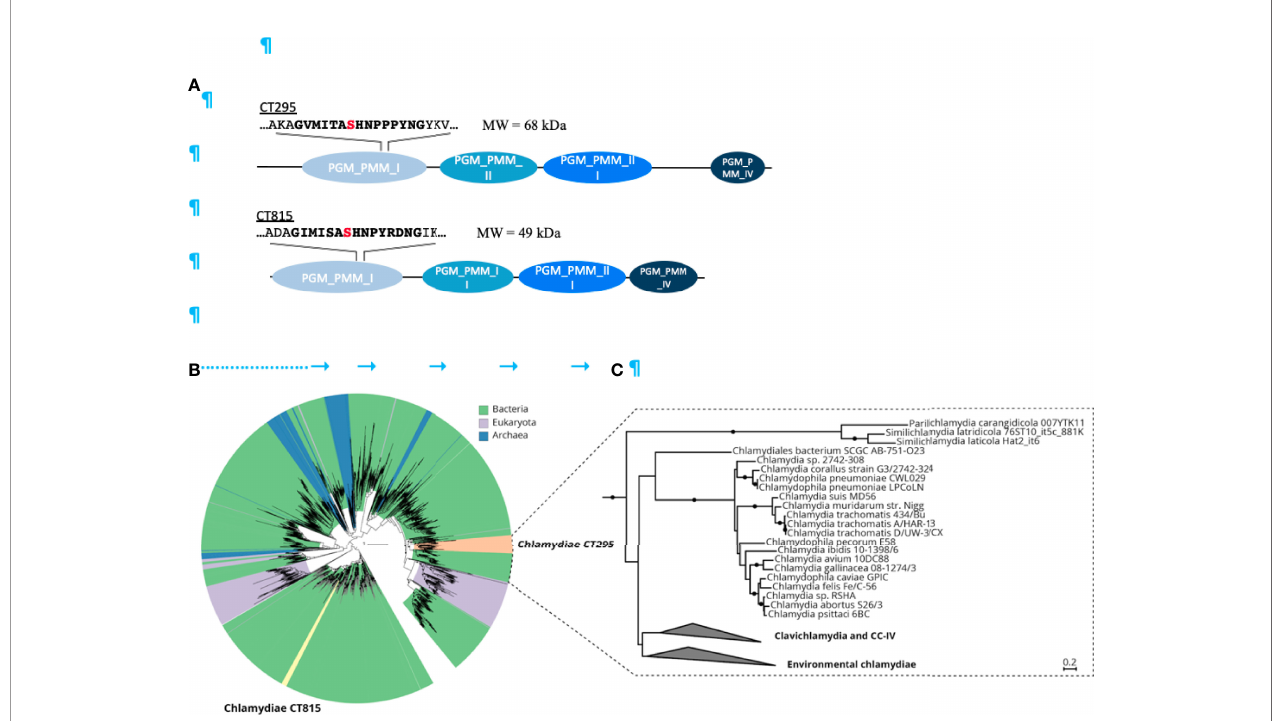
FIGURE 2 | The chlamydial candidate PGMs CT295 and CT815 are related with other bacterial PGMs, stem from an ancient gene duplication event and are both monophyletic. (A) – Schematic representation of the two putative PGMs from C. trachomatis . PGMs are composed of four phosphoglucomutase domains depicted in blue. The PGM conserved motif sequence is in bold with the serine involved in the phophoryl-transfer in red. (B) – Phylogenetic analysis of chlamydial CT295 and CT815 homologs in eggNOG COG1109 (annotated as “ phosphomannomutase ” ; 456 aligned positions) clustered at 80% amino acid identity over 90% query coverage (n = 2,829). Clades are colored by their af fi liation to bacteria, eukaryota, and archaea in green, violet, and blue, respectively. Orange indicates the chlamydial CT295 clade (bacterial eggNOG ENOG4107QSU), and yellow indicates the chlamydial CT815 clade (bacterial eggNOG ENOG4107QJF). Maximum likelihood phylogenetic trees with best fi t model LG+C60+G+F with 1,000 ultrafast bootstraps are shown. Bootstrap support for monophyly of chlamydial clades in the tree is ≥ 95%, and the SH-like approximate likelihood ratio is ≥ 80%. (C) – Phylogenetic analysis of chlamydial CT295 homologs (bacterial eggNOG ENOG4107QSU; n = 104) with its sister clade from COG1109 (575 aligned positions) used as outgroup (n = 93). Maximum likelihood phylogenetic tree based on LG+C60+G+F best tree using the posterior mean site frequency model and 100 non-parametric bootstraps. Bootstraps ≥ 70% are indicated by fi lled circles at splits in the tree. Scale bar indicates 0.2 substitution per